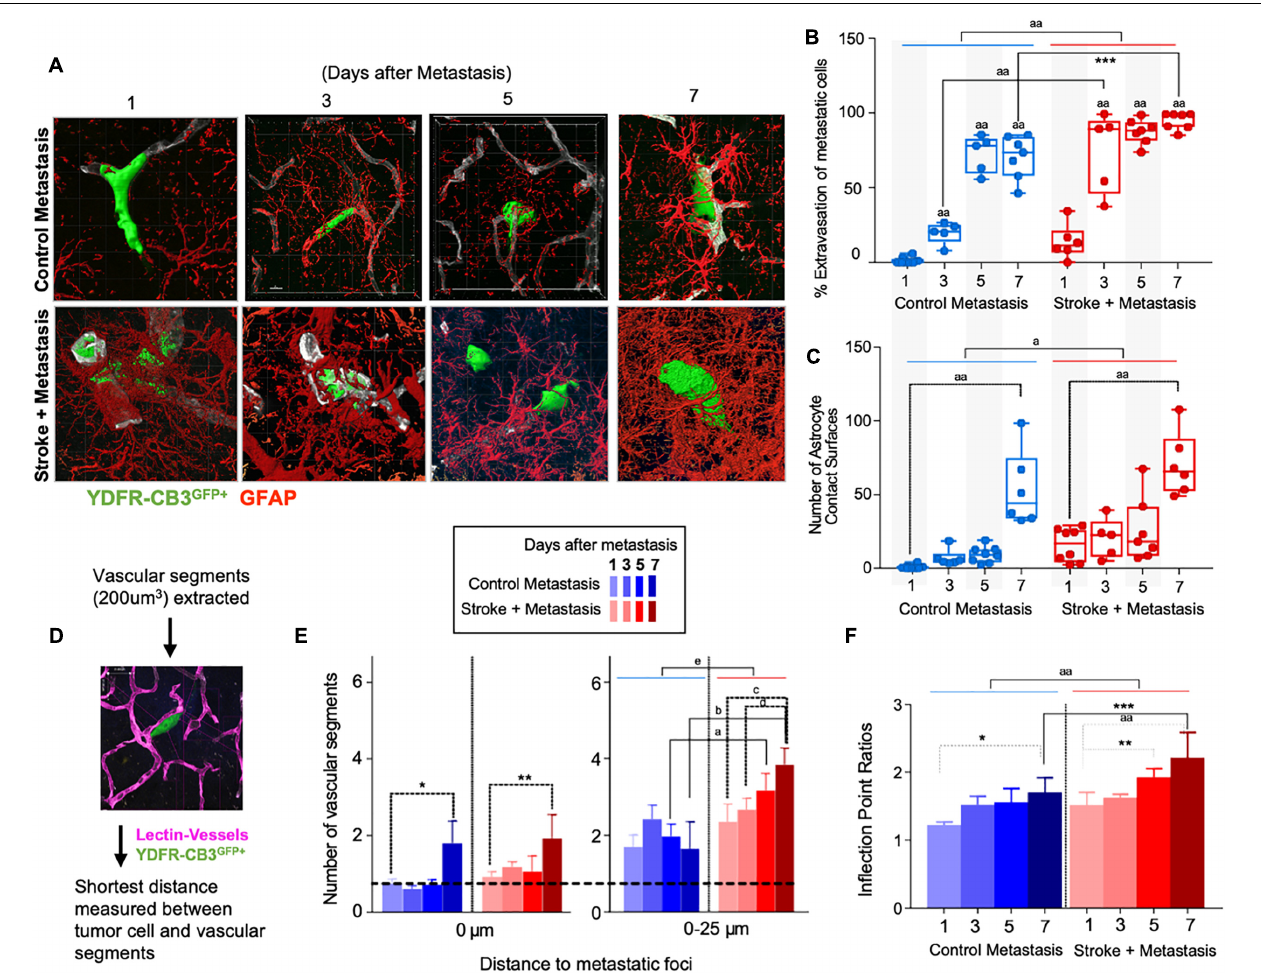
FIGURE 3 | Repair enhances direct cellular interactions between the metastatic cell and astrocytes and increases neovascularization. (A) Representative images showing metastatic melanoma interaction with reactive astrocytes during melanoma extravasation. (B) Quantitative analysis of % volume of metastatic cell extravasated. Mean ± SEM [ ∗∗∗ p = 0.0082, aa p < 0.0001, two-way ANOVA, Holm-Sidak post hoc test used for multiple comparisons ( n = 5–8)]. (C) Astrocyte coverage at corresponding time points around each metastatic foci. Mean ± SEM [ aa p < 0.0001, a p = 0.0006, two-way ANOVA, Holm-Sidak post hoc test used for multiple comparisons ( n = 5–8)]. (D) Methodology of analysis of neovascularization and infection point analysis. (E) Changes in neovascularization response over time mean ± SEM, ( n = 5–8), ( ∗ p = 0.0424, ∗∗ p = 0.0349, a p = 0.0454, b p = 0.0015, c p = 0.0163, d p = 0.0474, e p = 0.0009, two-way ANOVA, Fisher LSD). (F) Bar graphs showing temporal changes in inflection point ratios [ ∗ p = 0.0032, ∗∗ p = 0.0215; ∗∗∗ p = 0.0012; aa p < 0.0001; two-way ANOVA, Holm-Sidak post hoc test used for multiple comparisons, ( n =